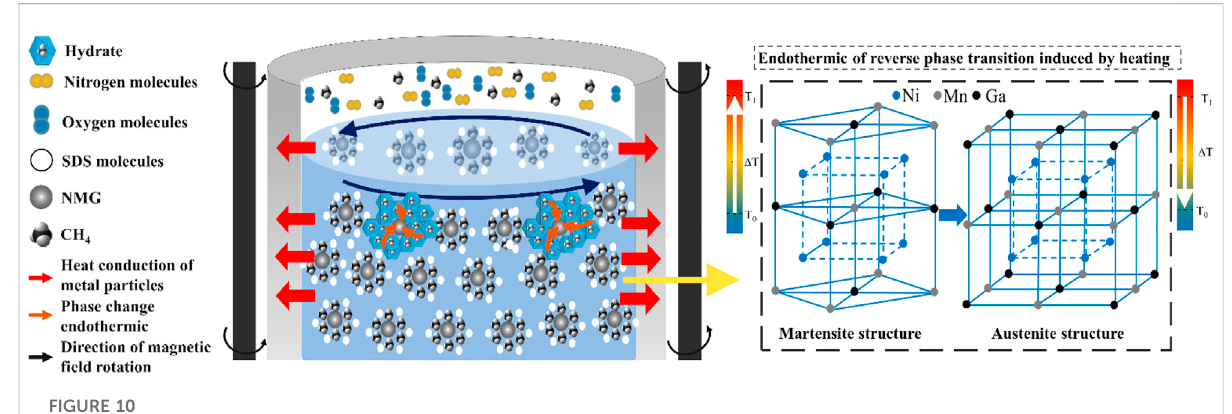
FIGURE 10 Schematic illustrations of gas hydrate formation and heat